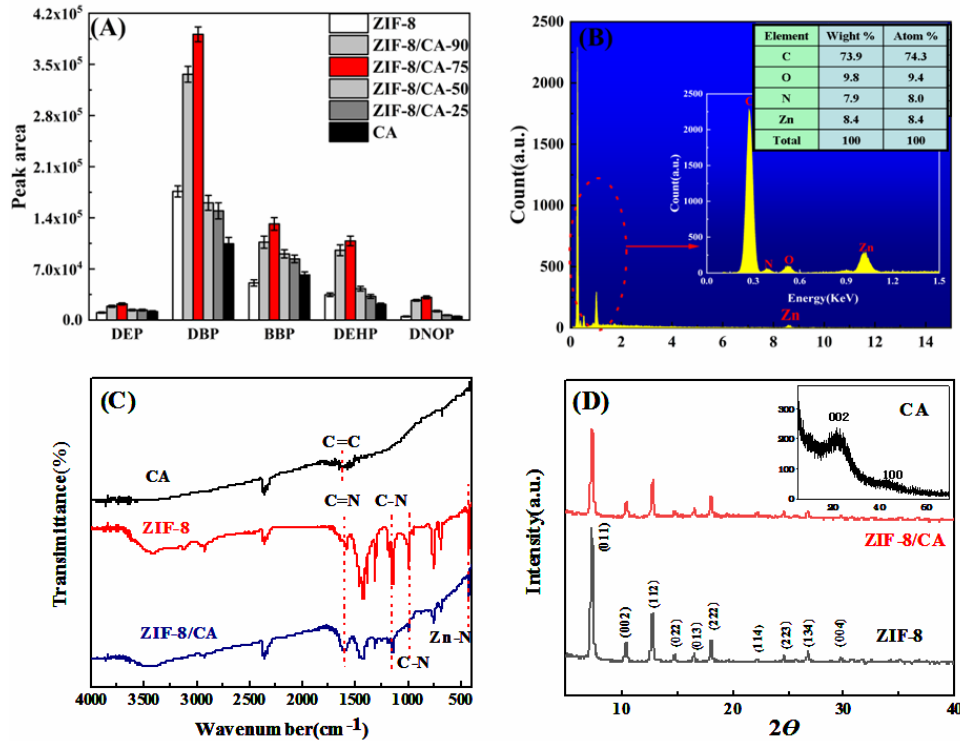
Figure 2. ( A ) Comparison of different mass ratio of composites based on peak area; EDX spectrum ( B ) of ZIF-8/CA; FT-IR patterns ( C ) of CA, ZIF-8, ZIF-8/CA; XRD spectrum ( D ) of ZIF-8, ZIF-8/CA, and CA (the inset).